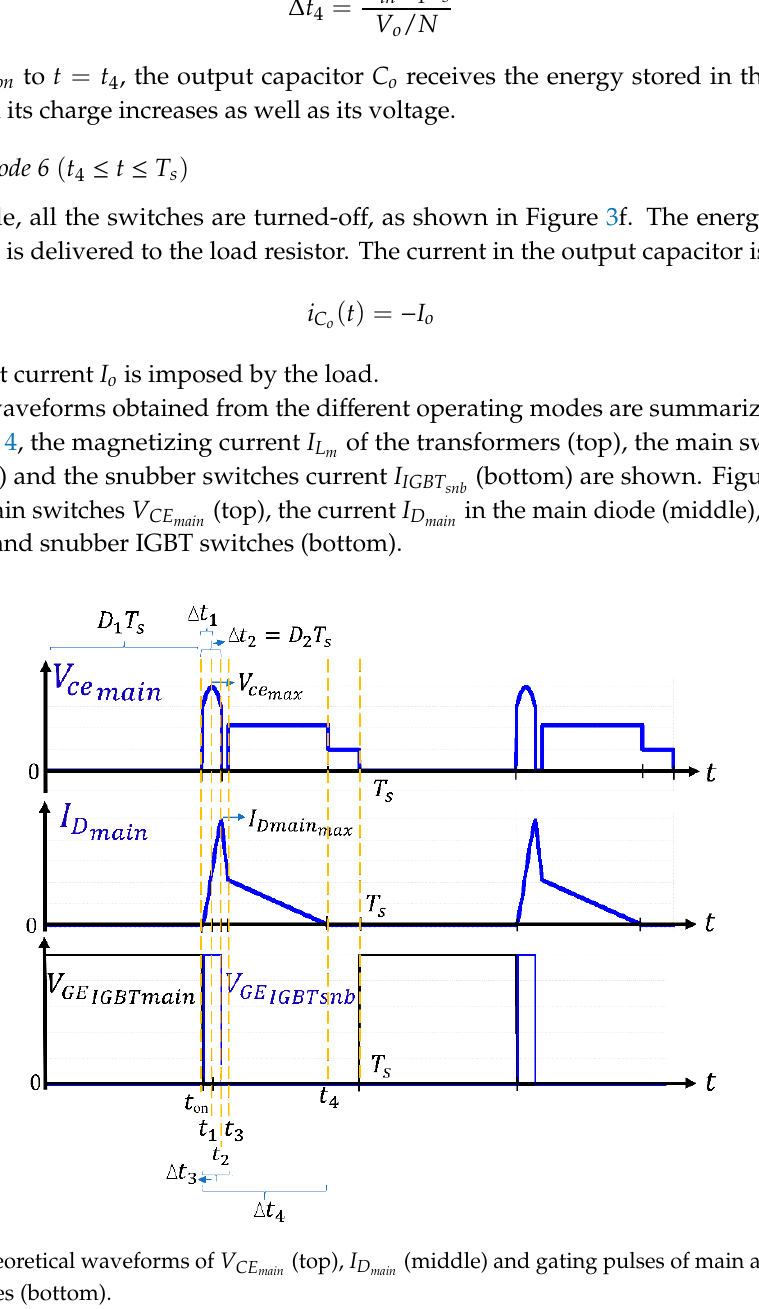
(top), I D (middle) and gating pulses of main and snubber (top), 𝐼 (cid:3005) (middle) and gating pulses of main and main main (cid:3288)(cid:3276)(cid:3284)(cid:3289) (cid:3288)(cid:3276)(cid:3284)(cid:3289)